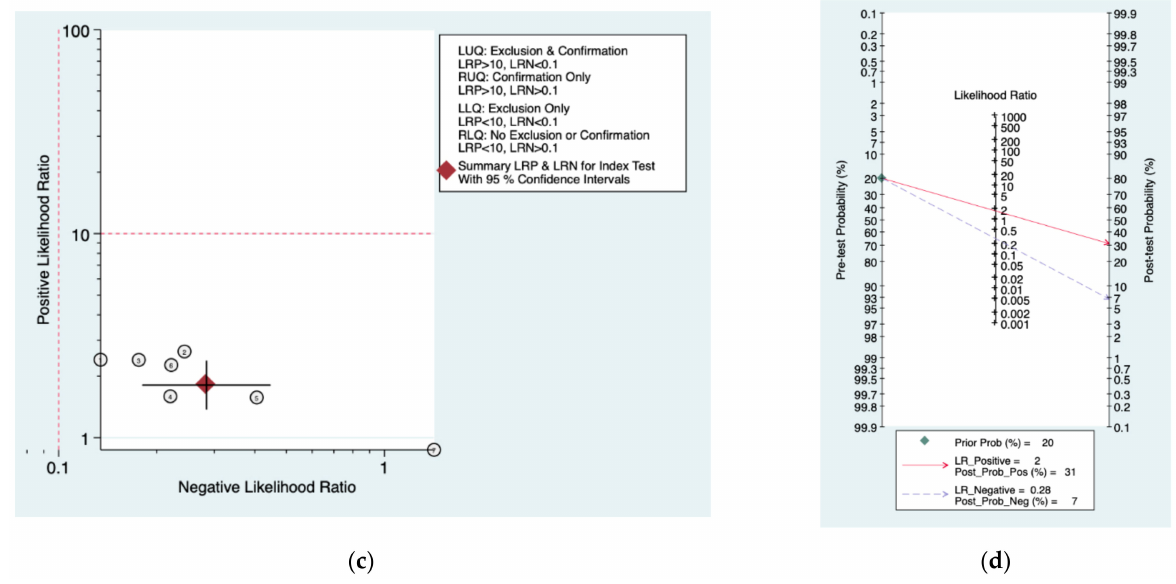
Figure 7. Meta‑analysis of Seattle protocol. ( a ) Forrest plot of pooled sensitivity and